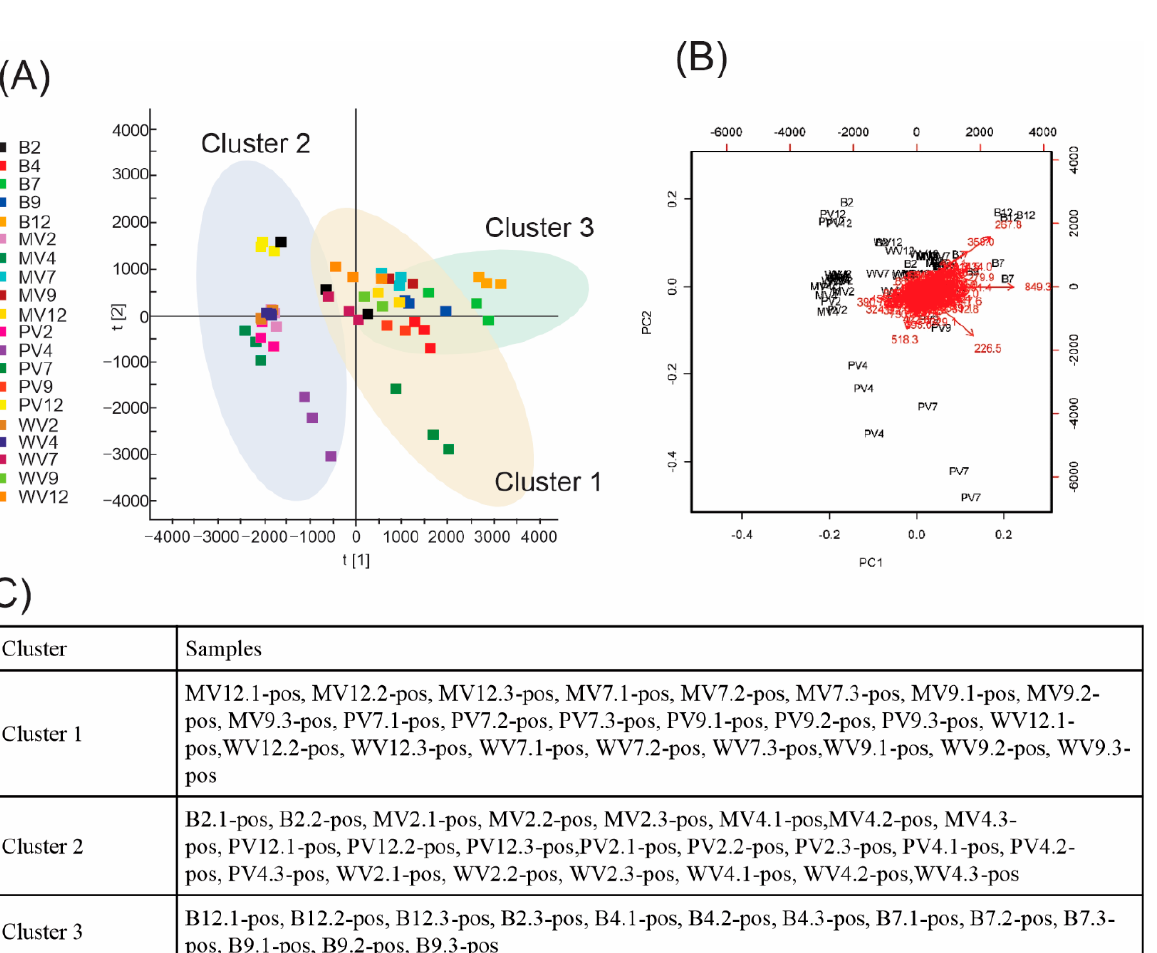
Figure 2. Unsupervised analyses of data acquired in positive mode: (A) Principal components analyses (PCAs)—symbols within the delimited transparent areas are those that form clusters defined by k-means. (B) Bi-plot analysis (scores × loadings). (C) K-means clusters.